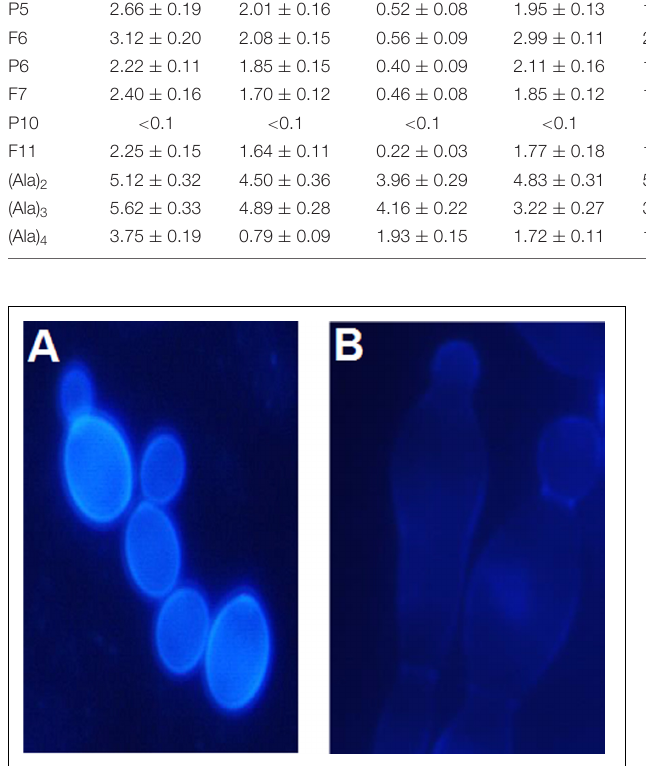
FIGURE 2 | Morphological changes induced in C. albicans SC 5314 cells upon action of F11. Cells were stained with Calcofluor White for chitin. (A) Control—untreated cells. (B) Cells treated with F11, 100 µ g mL − 1 .